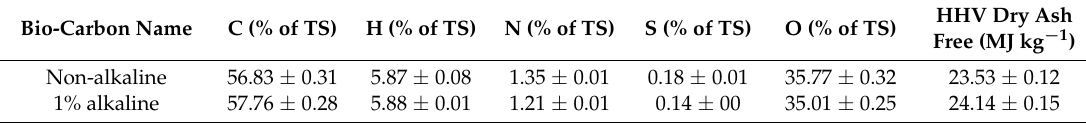
Table 3. CHNSO content and HHV of non-alkaline and 1% alkaline hydrothermal process produced bio-carbon in ash free